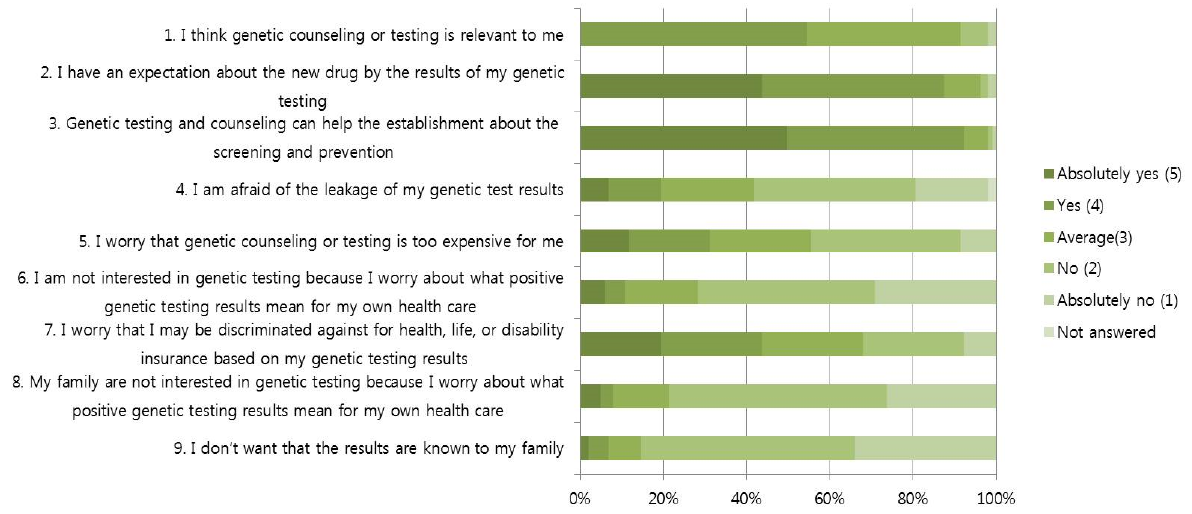
Figure 1. Attitude to next-generation sequencing.